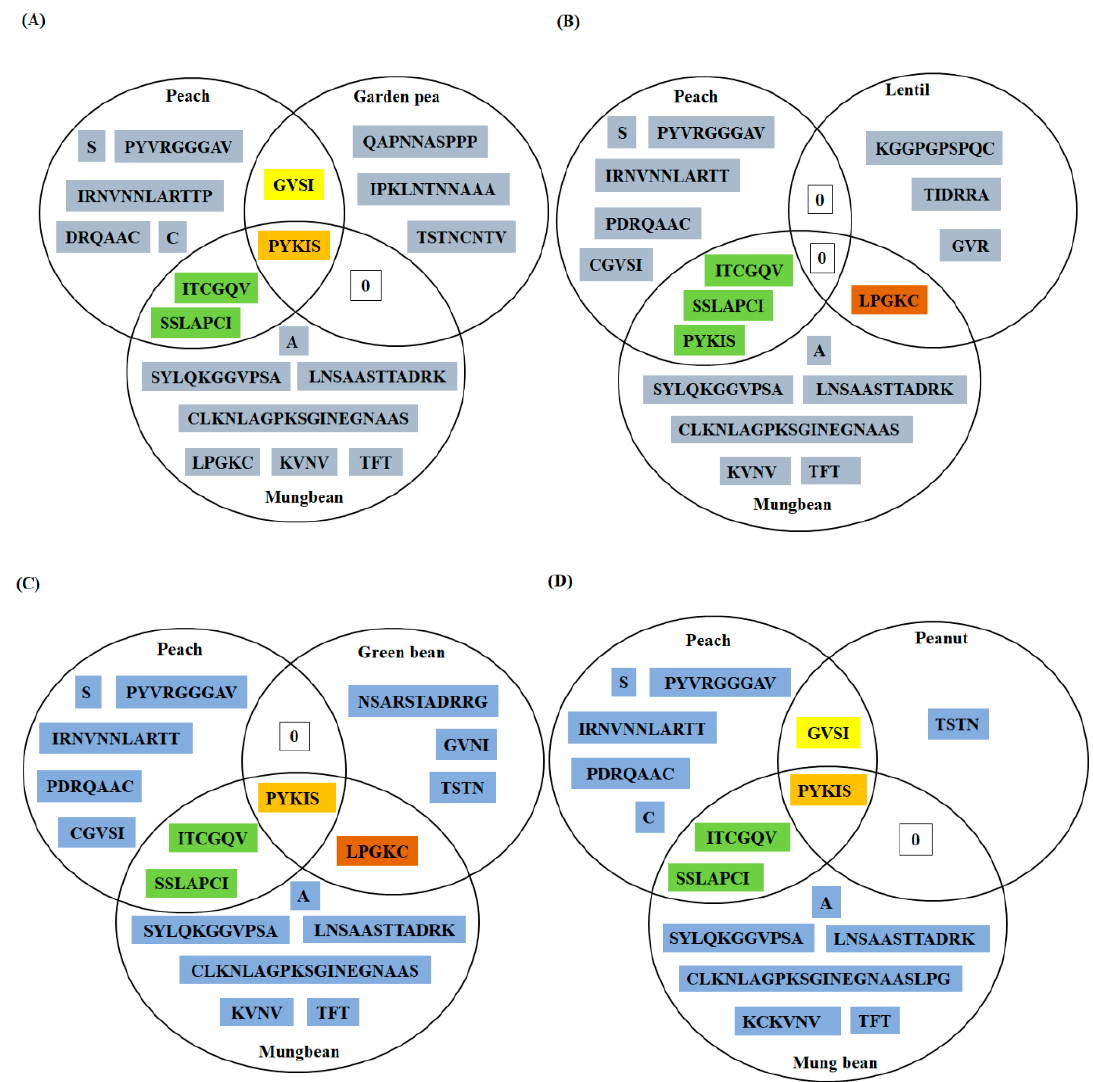
Figure 4. Triads were used for comparing the predicted epitopes of mung-bean LTP with the predicted epitopes of peach and other four allergenic legumes. Total four Venn diagrams were generated for mung-bean LTP, i.e., mung-bean and peach were common to each diagram, only replacement was the allergenic legume LTP, in the order—( A ) garden pea, ( B ) lentil, ( C ) green bean, and ( D ) peanut, respectively. Only predicted epitopic residues were mentioned in the diagram and ‘0’ denoted absence of any identical regions.